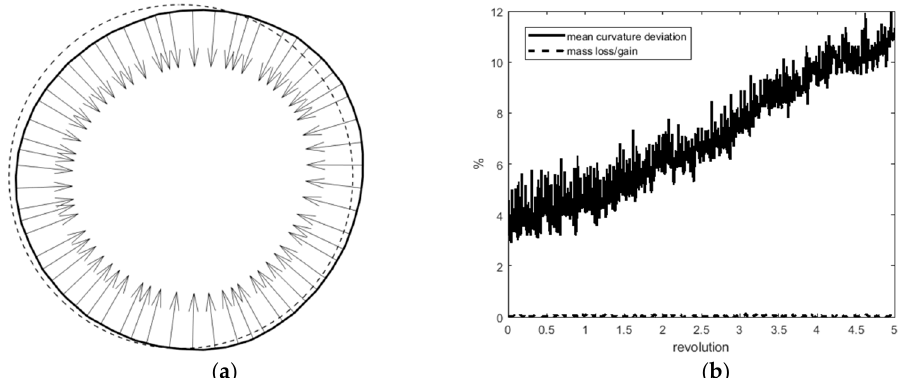
Figure 6. Five revolutions of a circle using a 50 × 50 structured mesh, using the improved conservative direct re-initialization or ICDR ( a ) An original circle before (dashed line) and after five revolutions